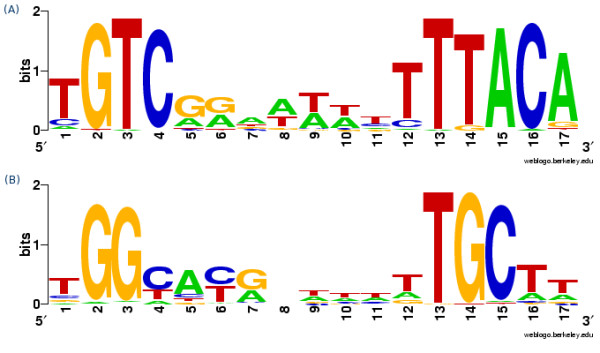
a) Consensus sequence LOGO [27] of motif 1 of the upstream region of PEP-CTERM genes in the Proteobacteria. Motif 1 is the predicted binding site for the PEP-CTERM regulatory system response regulator. b) Consensus sequence LOGO of motif. This motif includes the -24(GG)/-12(GC) pattern of RNA polymerase sigma-54 binding sites.